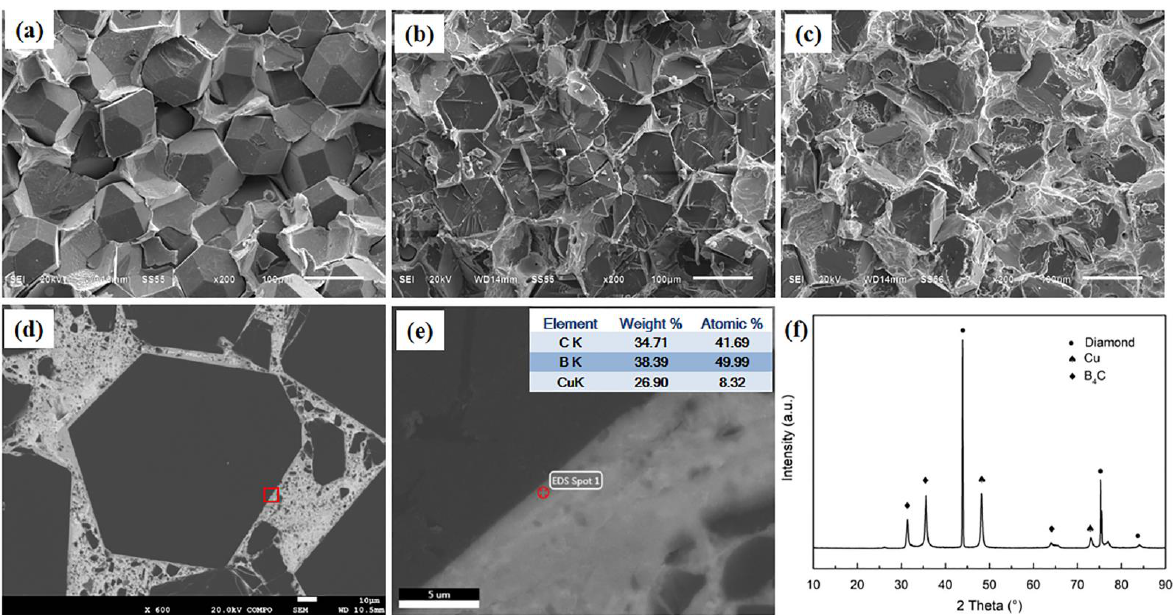
Figure 2. SEM images for the fractured surfaces of: ( a ) diamond/Cu; ( b ) diamond/Cu-B composites with 0.5 wt.% boron; ( c ) diamond/Cu-B composites with 1.0 wt.% boron; ( d ) polished surface of diamond/Cu-B composites ( b ); ( e ) element analysis of interface area in ( d ); and ( f ) XRD patterns of diamond/Cu-B composites ( b